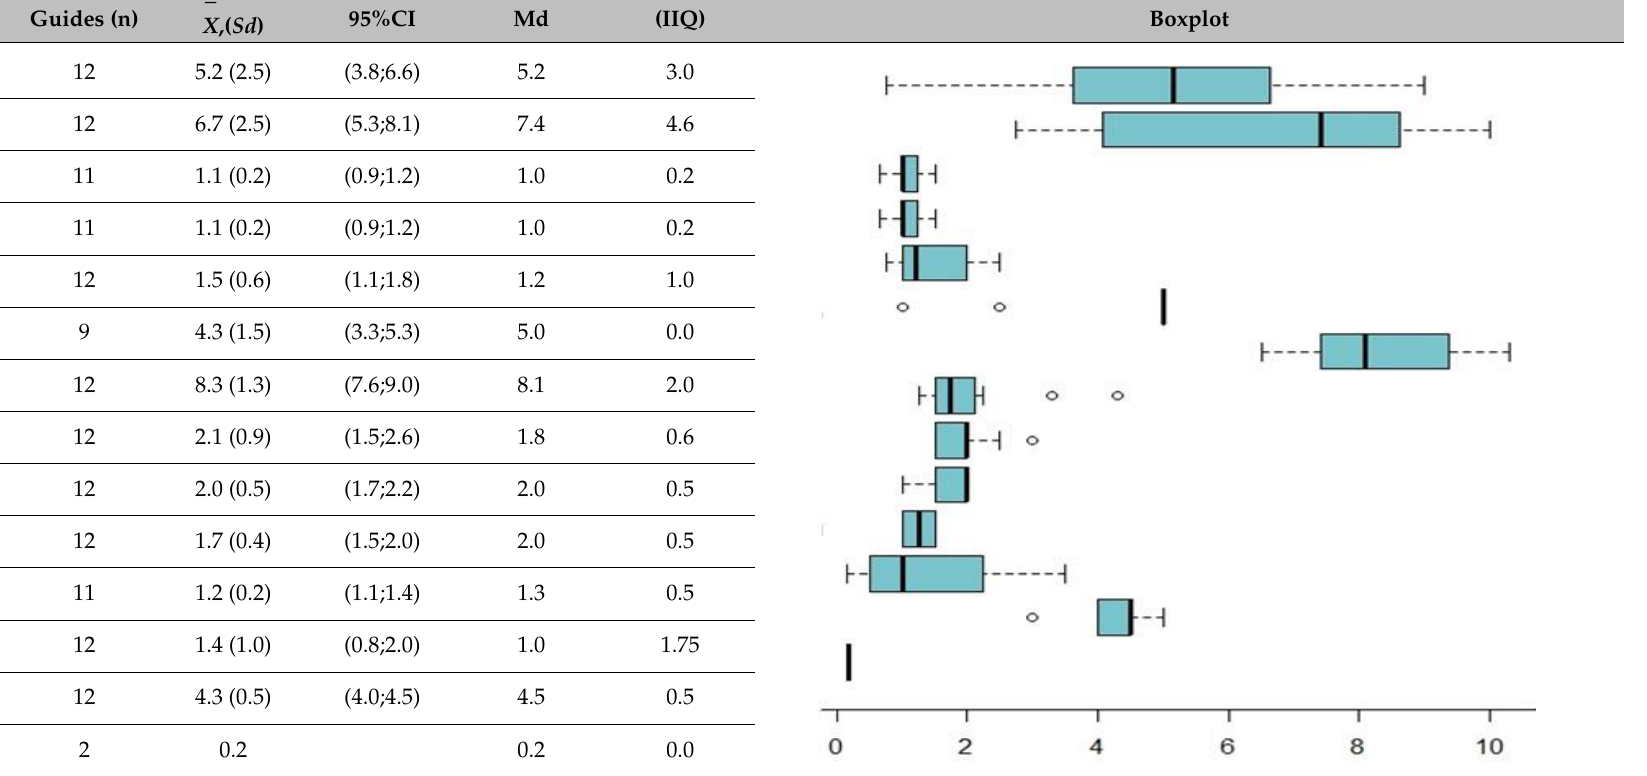
Table 2. Weekly frequency for the provision of food groups (healthy) suggested in the guides for school food services in Spain. Recommended foods